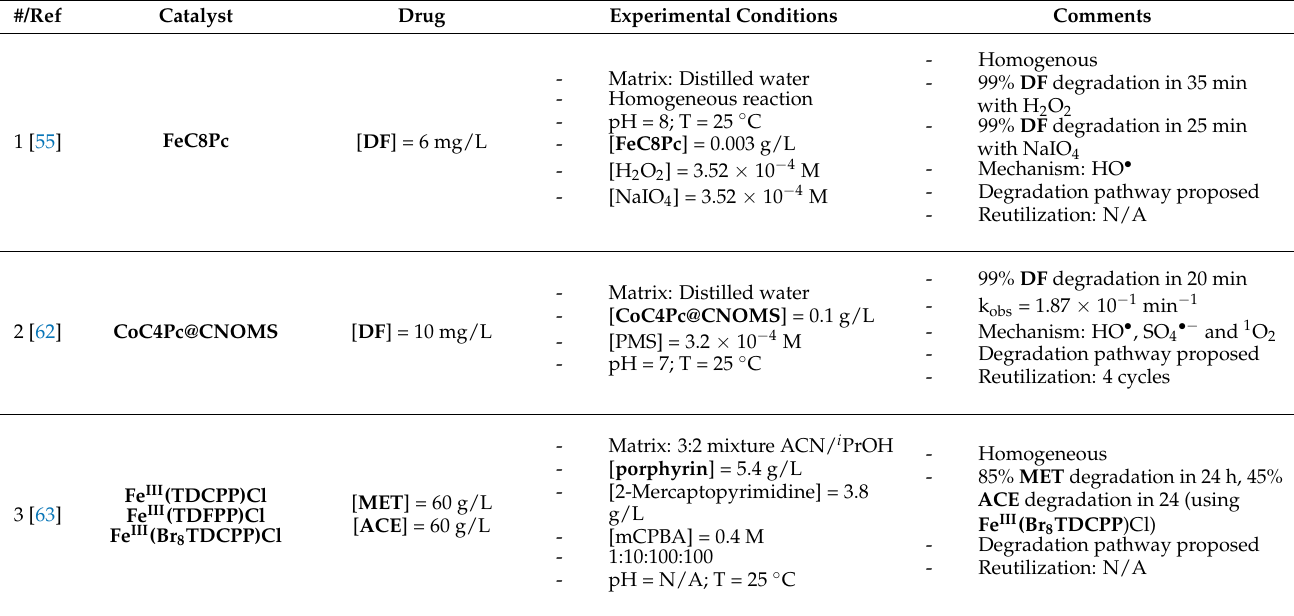
Figure 8. Structures of tetrapyrrolic macrocycles (TPM) used as catalysts for oxidative chemical degradation of analgesic pharmaceuticals. Table 4. Nonphotochemical degradation of analgesic drugs using TPM-based